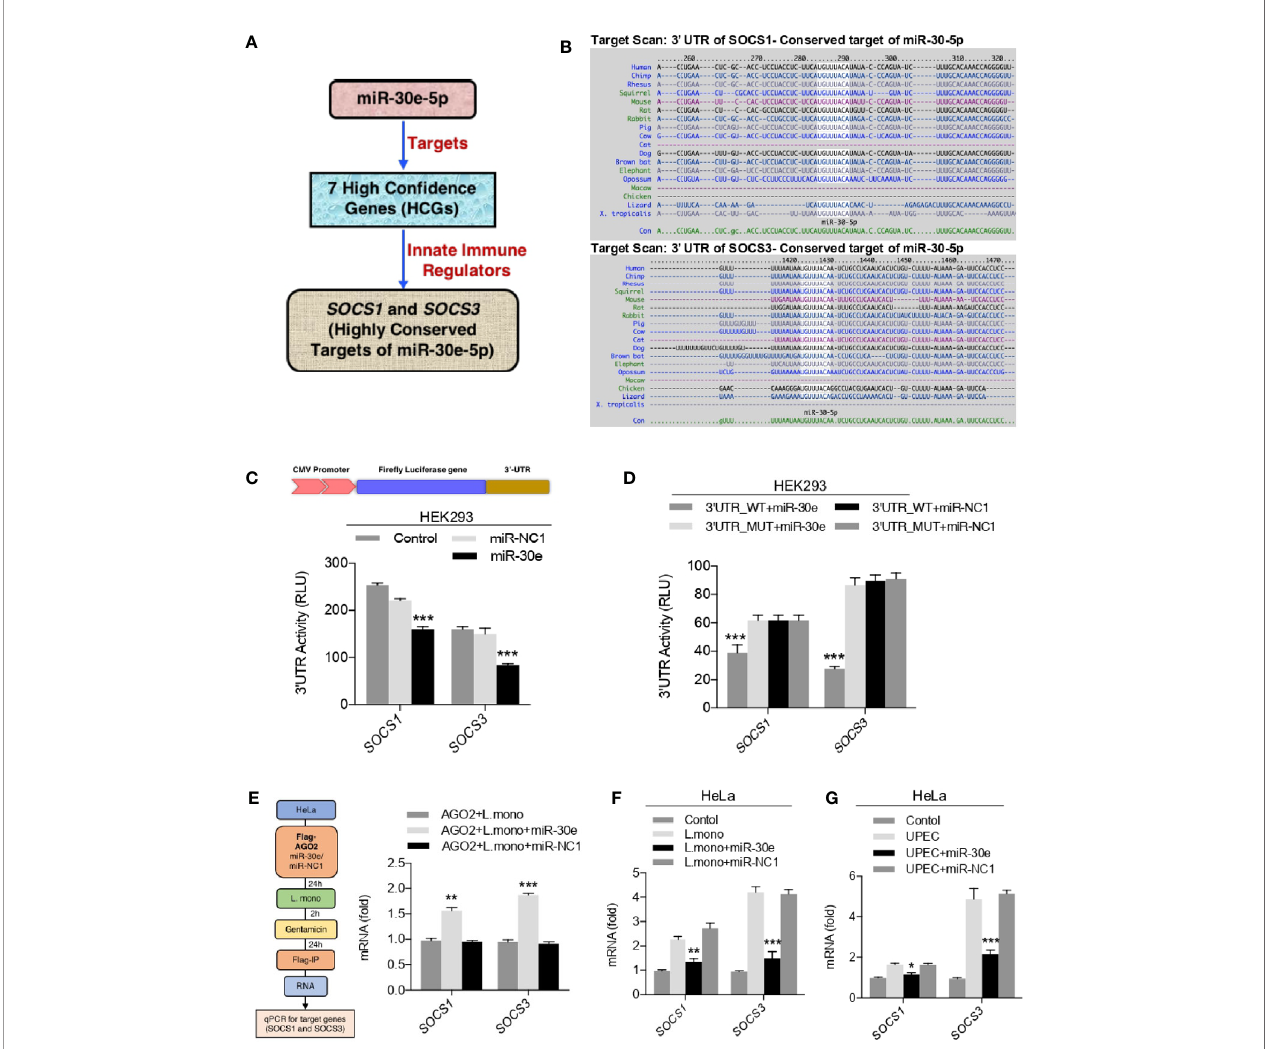
FIGURE 2 | miR-30e-5p targets SOCS1 and SOCS3 . (A) Schematic of miR-30e-5p targeting of innate immune regulators. (B) miR-30-5p binding 3 ’ UTR site conservation of SOCS1 and SOCS3 among wide range of species. (C, D) HEK293 cells were transfected with 50 ng of pRL-TK and 300 ng of 3 ’ UTR_WT or 300 ng of 3 ’ UTR_MUT (of indicated genes) together with 25 nM miR-30e or miR-NC1 mimics, 24 h after transfection, the cell was lysed and subjected to luciferase assay. (E) Schematic for RNA-immunoprecipitation assay. HeLa cells were transfected with plasmid encoding Flag-AGO2 in presence of miR-30e (50 nM) and miR-NC1 (50 nM) and then infected with L. mono. (50 MOI). Serum-free media of cells were replaced after 2 h with complete media containing gentamicin. After 24 h cells were subjected to RNA immunoprecipitation and quanti fi ed for SOCS1 and SOCS3 transcripts. (F, G) Quanti fi cation of the fold changes by qRT-PCR analysis in the relative abundances of SOCS1 and SOCS3 after infection of (F) L. mono. (50 MOI) and (G) UPEC (50 MOI) for 24 h in HeLa cells prior to transfected with miR-30e or miR-NC1 as indicated. Data are mean +/- SEM of triplicate samples from single experiment and are representative of two (E) and three (C, D, F and G) independent experiments. *** P < 0.001 and * P < 0.05 by one-way ANOVA Tukey